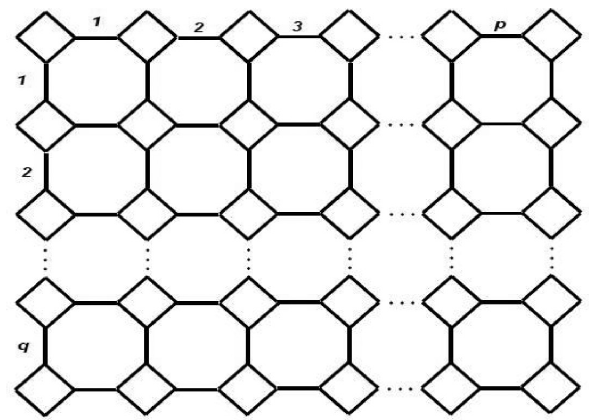
Figure 4: Type-II C